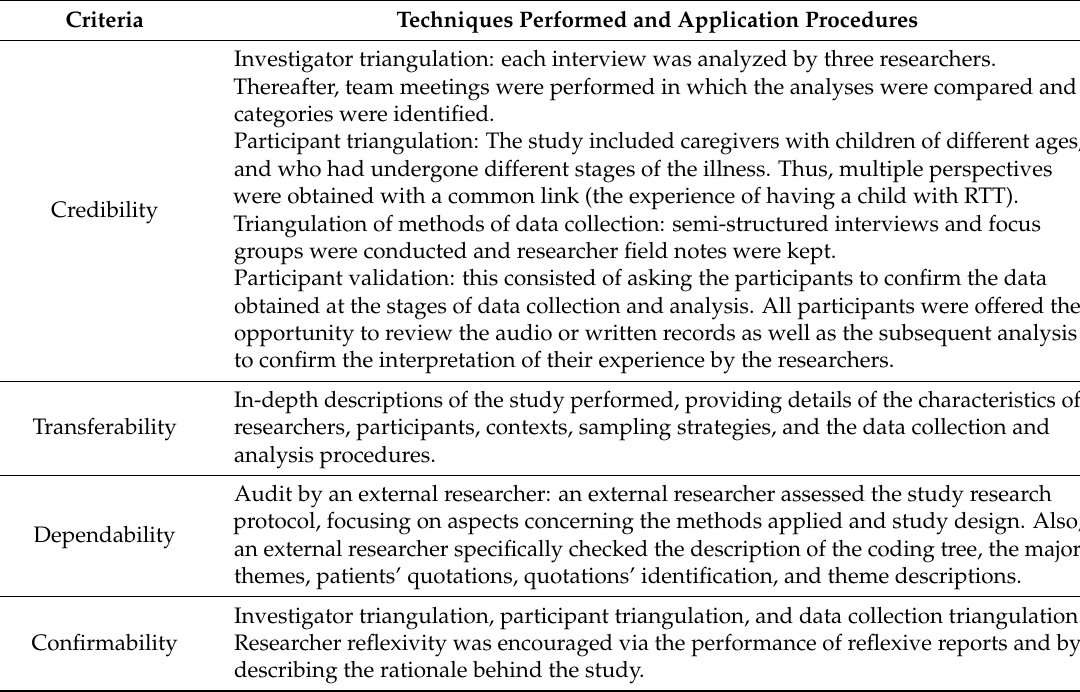
Table 3. Trustworthiness